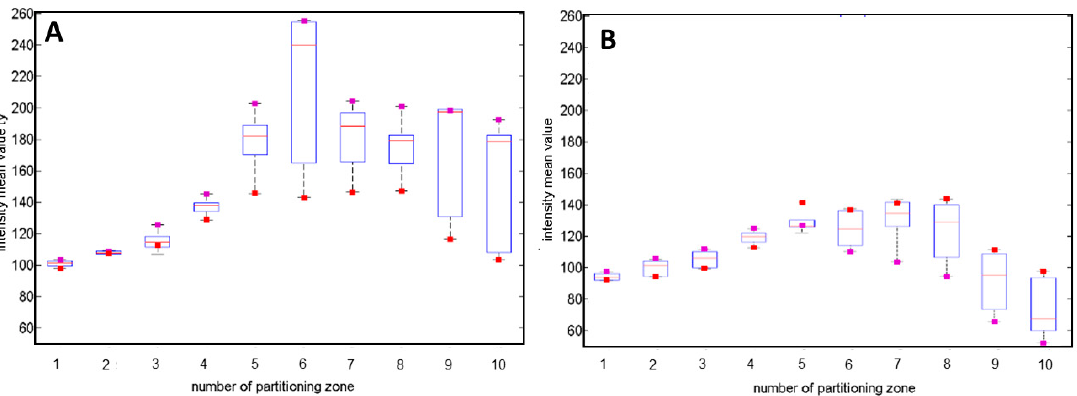
Figure 5. The representative boxplots demonstrating the variation of the di ff raction patterns’ mean intensities across 10 partitioning zones of: ( A ) upper (for Θ = 0 ◦ –180 ◦ ) and ( B ) lower (for Θ = 180 ◦ –360 ◦ ) parts of the di ff raction pattern (red square—mean intensity value of centered pattern for ∆ r = 0 µ m; violet square—mean intensity value of the decentered patterns for ∆ r = + 500 µ m). Results obtained based on 200 di ff raction patterns.